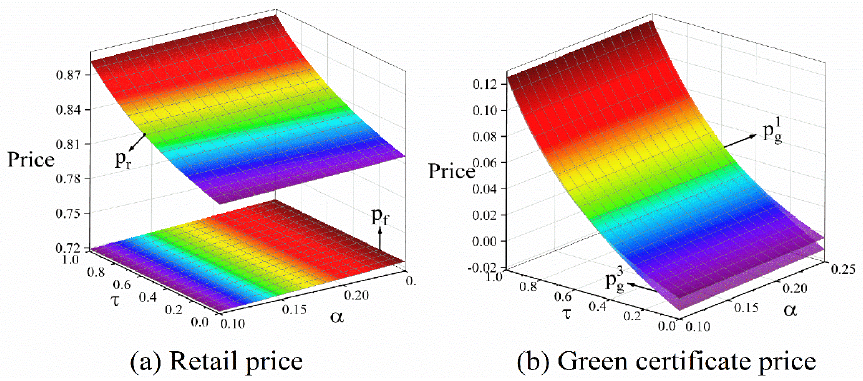
Figure 9. The trend of price under different levels of α and τ.